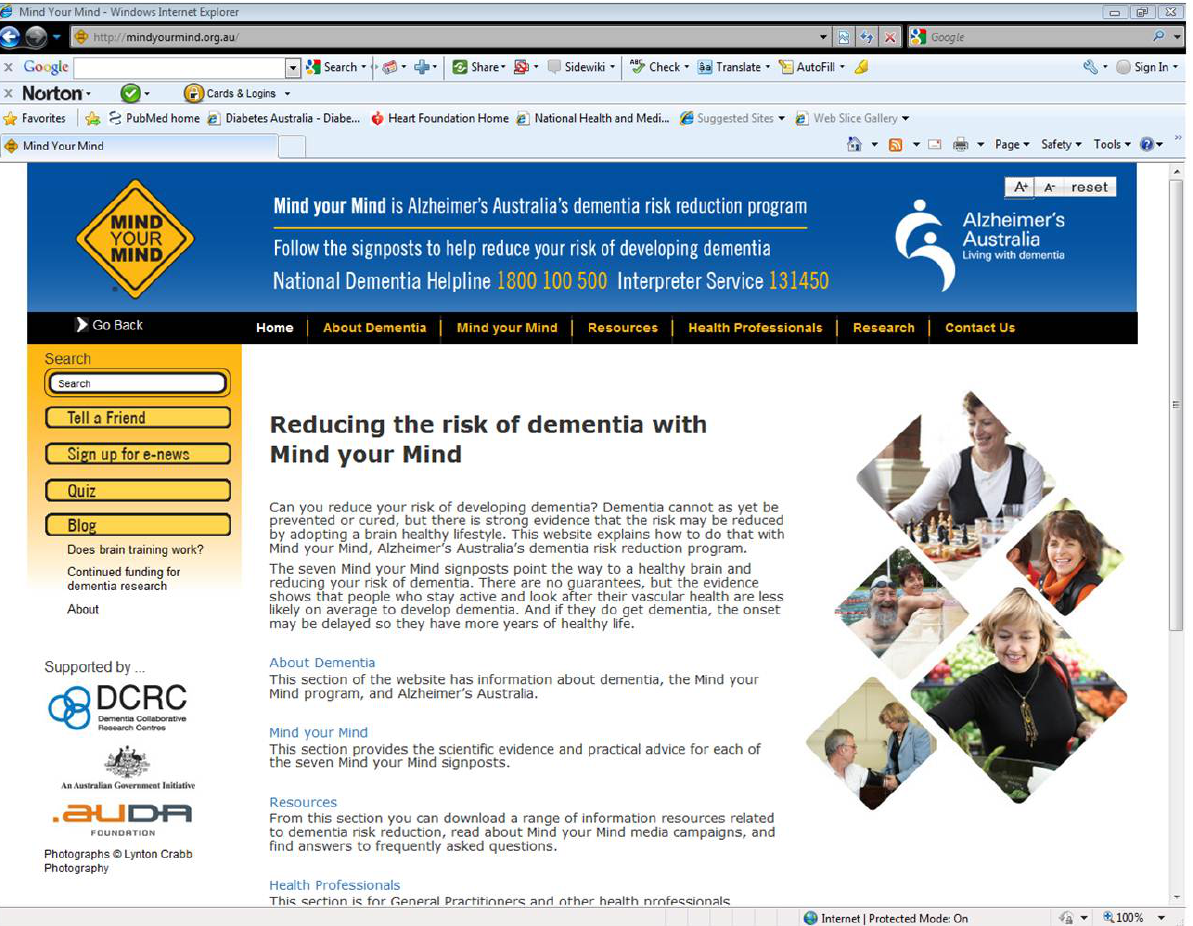
Figure 1. Screenshot of the Mind your Mind website home